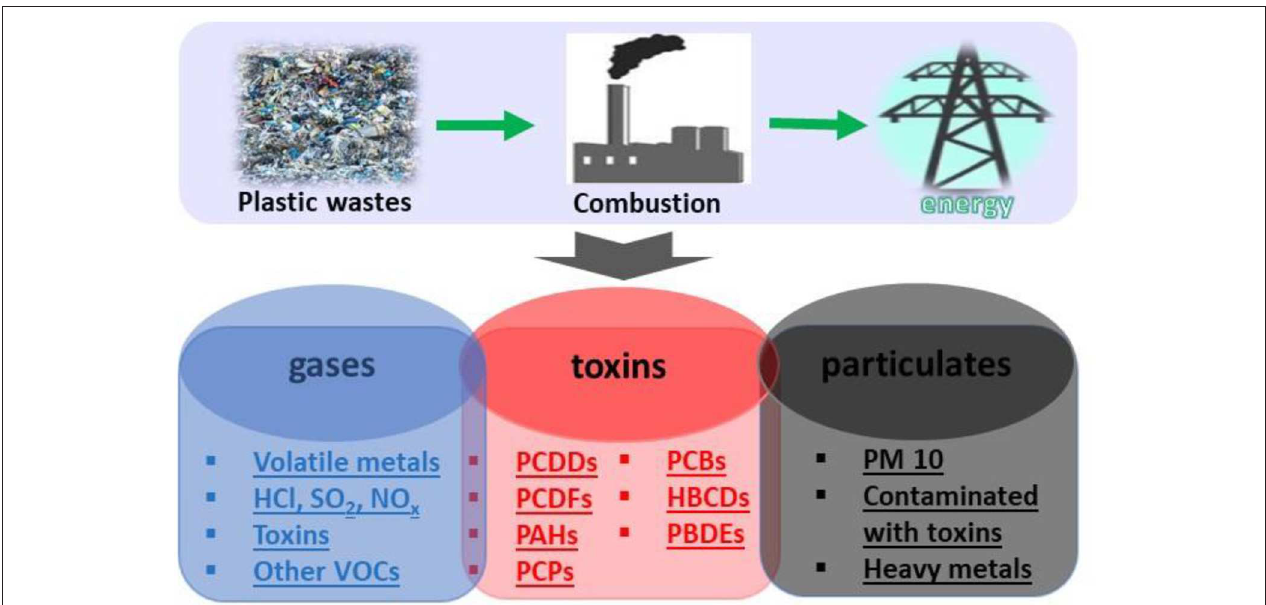
FIGURE 1 | Major pollutants generated during the incineration of waste plastics. Chemicals and abbreviations: PCDDs, Polycholorinated dibenzo-p-dioxins; PCDFs, Dibenzofurans; PAHs, Polycyclic aromatic hydrocarbons; PCPs, Pentachlorophenols; PCBs, Polychlorobenzenes; HBCDs, hexabromocyclodedecanes; PBDEs, polybrominated diphenyl